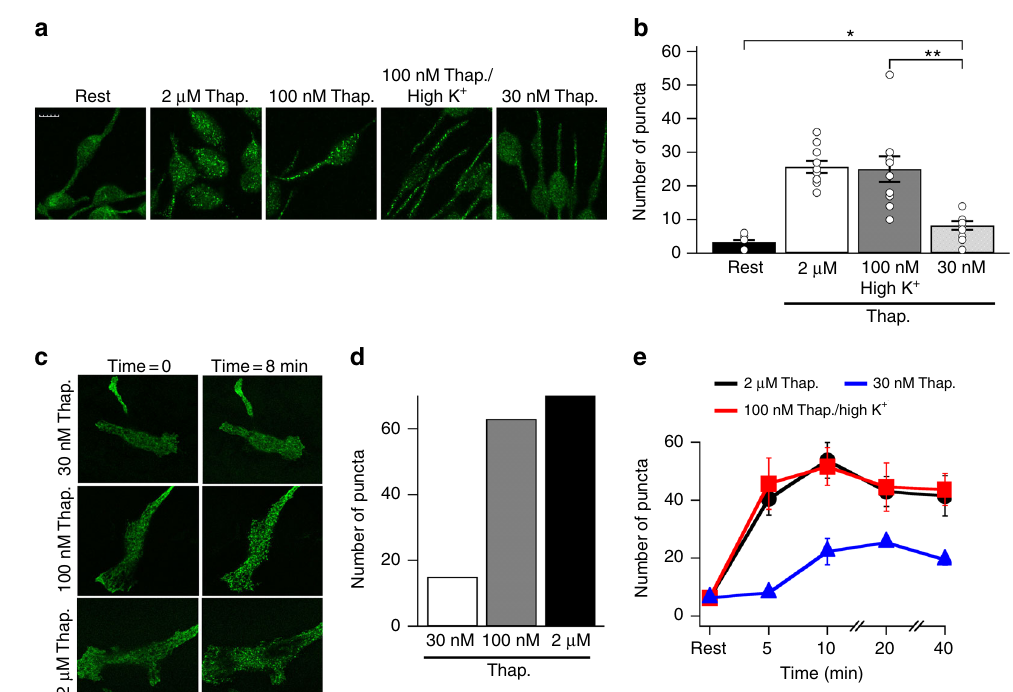
Fig. 2 Increasing thapsigargin concentration recruits more STIM1 puncta. a Endogenous STIM1 puncta are compared for the conditions shown. Cells were fi xed 10 min after stimulation. Rest denotes non-stimulated cells that were kept in standard solution for 10 min prior to fi xing. Whole scale bar is 10 μ m. b Aggregate data from experiments as in panel a are compared. Each bar denotes > 10 cells. c Snapshots from live imaging experiments are shown from cells expressing STIM1-YFP. Time = 0 denotes STIM distribution just prior to thapsigargin application. Time = 8 min denotes images taken 8 min after thapsigargin exposure. d Aggregate data are compared. e The number of STIM1-YFP puncta are compared over time following stimulation with thapsigargin at the concentrations indicated. Each point is the mean of > 10 cells. *denotes p < 0.05 and ** p < 0.01, determined using unpaired Student ’ s t - test. Error bars denote 100 nM thapsigargin in high K + solution, despite both stimuli increasing bulk cytosolic Ca 2 + to similar levels.